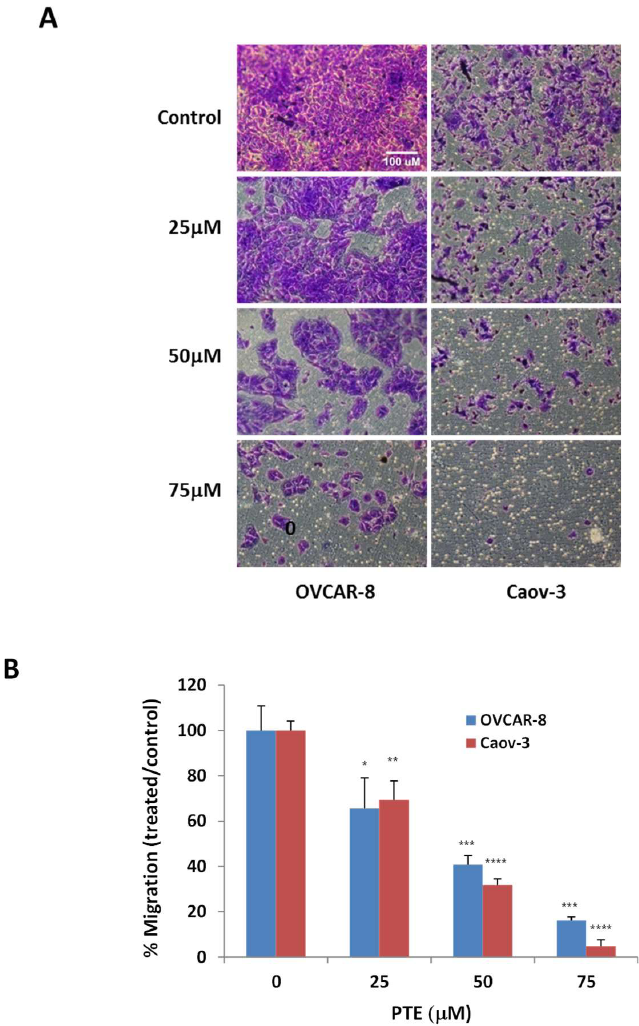
Figure 4. Pterostilbene inhibits cell migration. OVCAR-8 and Caov-3 cells were placed in the upper chamber of a transwell in the presence of various concentrations of PTE. Migrated cells were quantified 2 days after incubation. ( A ) Representative fields of migration for OVCAR-8 and Caov-3 cells. ( B ) The quantification of migration. Data were expressed as a ratio to vehicle control. Results are representative of 3 or more experiments, each with 3 or more replicates. *, p < 0.05, **, p < 0.005, ***, p < 0.0005, ****, p < 0.0001, versus control treated with vehicle.